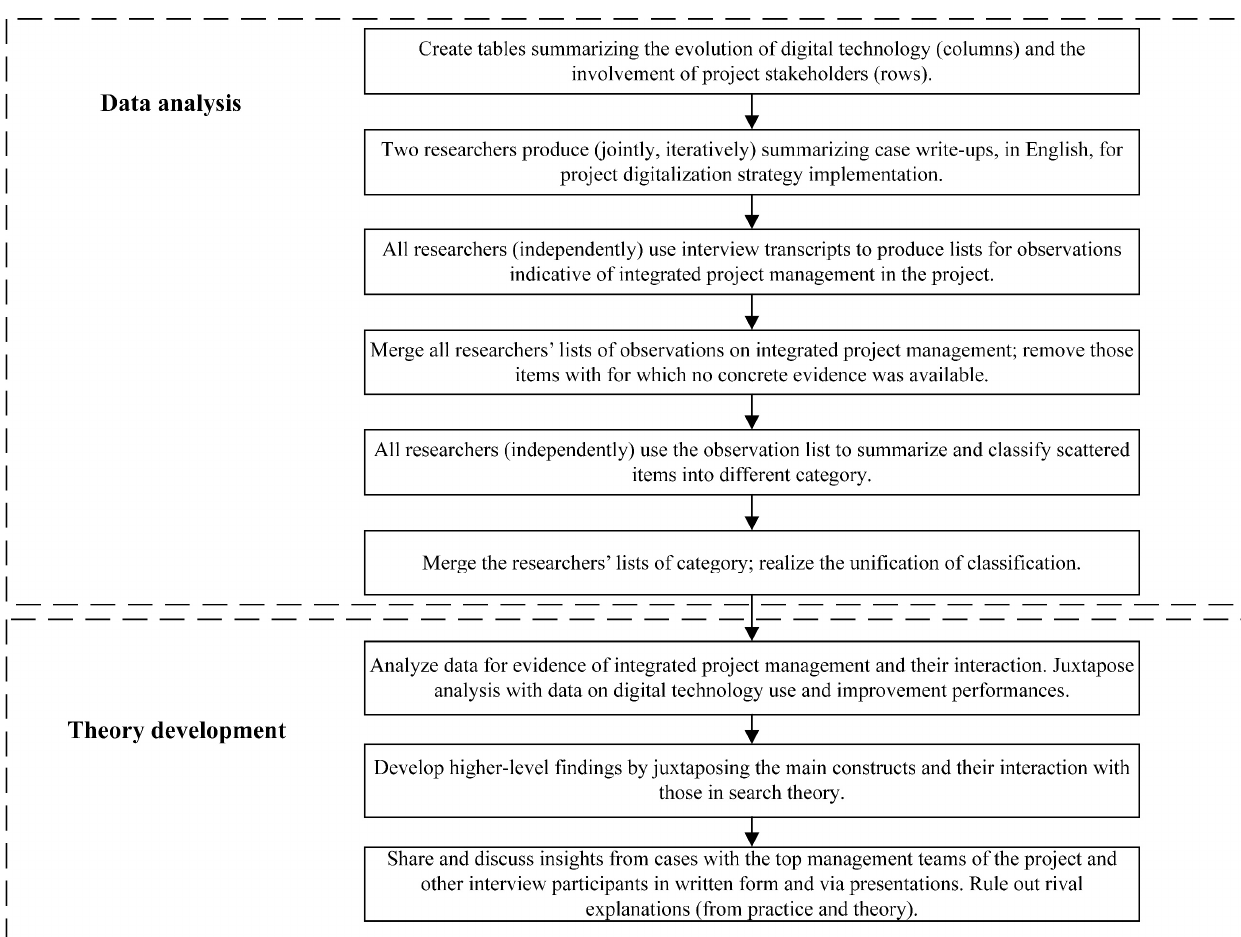
Figure 2. Detail process for data analysis and theory development.